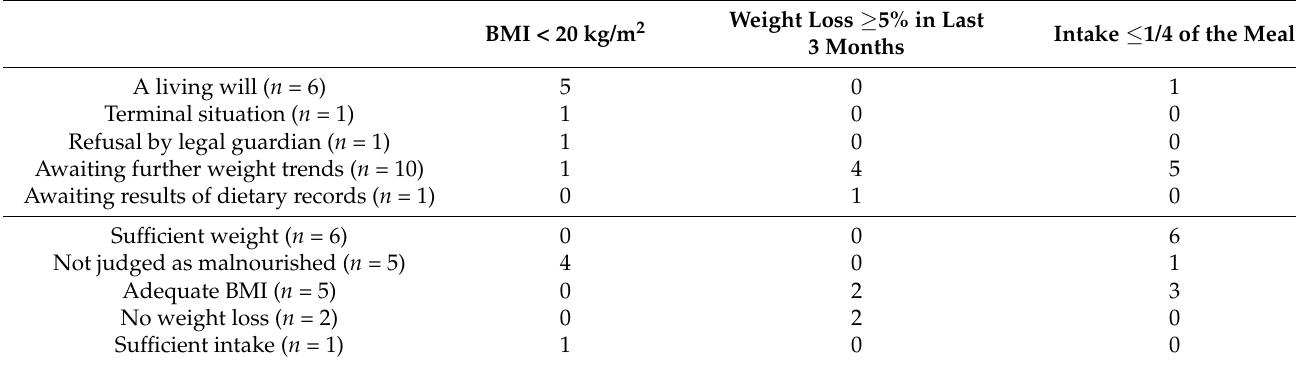
Table 2. Reasons against nutritional interventions (NI) stated by nursing staff and presence of objective signs of malnutrition in 38 objectively malnourished residents who did not receive NI. Numbers in () represent number of residents with the respective